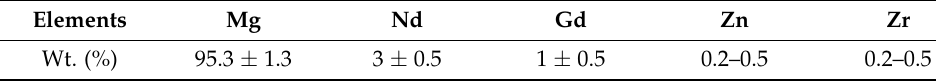
Table 1. Elemental composition of EV31A Mg alloy.